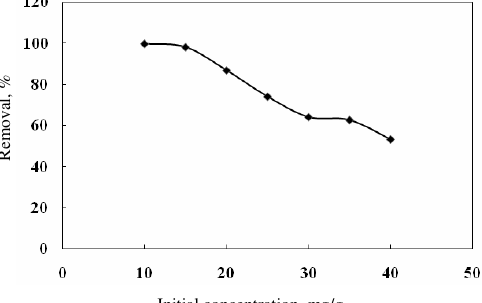
Figure 6 . Effect of initial dye concentration on removal of CR at 0.025 g of PtN-AC in 50 mL,